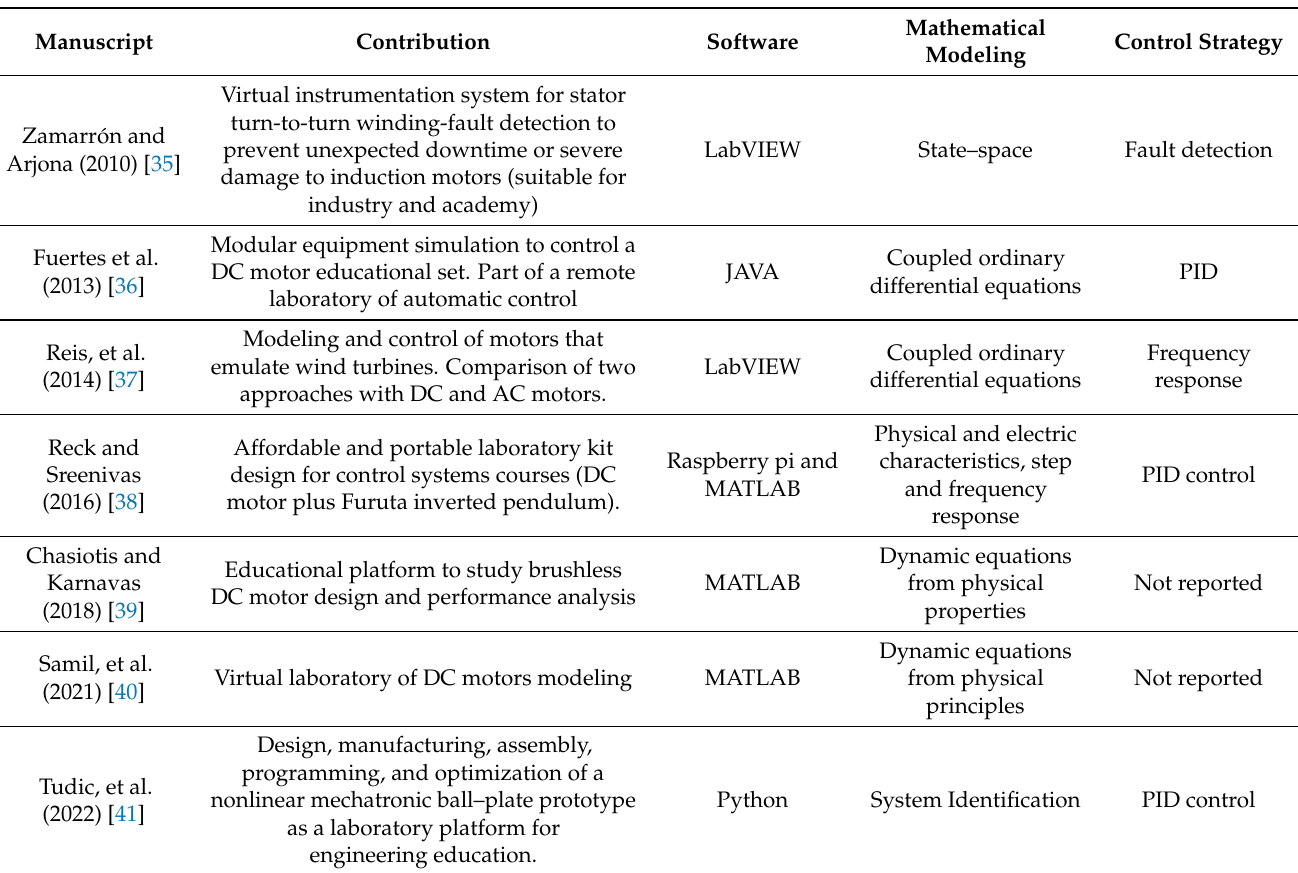
Table 1. State-of-the-art mathematical modeling, simulation, and control systems of electric motors for teaching/research in engineering academic